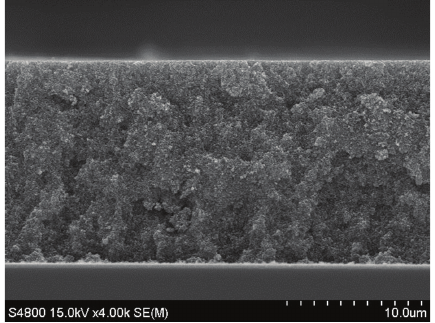
Figure 2: The FESEM image of the cross-section of the fabricated TiO 2 thin